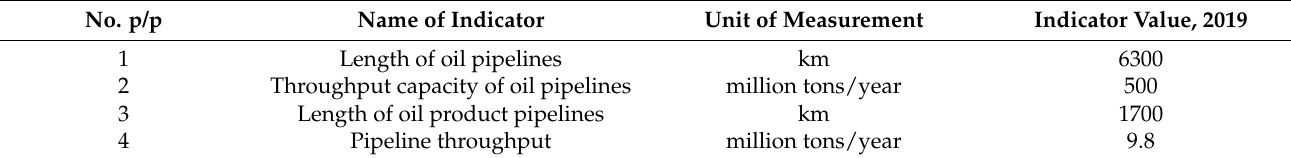
Table 6. Main characteristics of pipelines in Iraq,